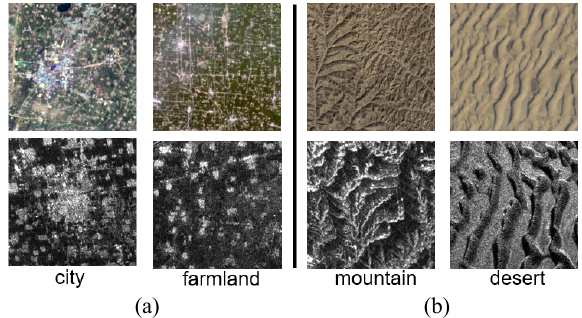
Figure 4 . Small interclass distance. (a) Similar objects between different scenes. (b) Similar textures between different